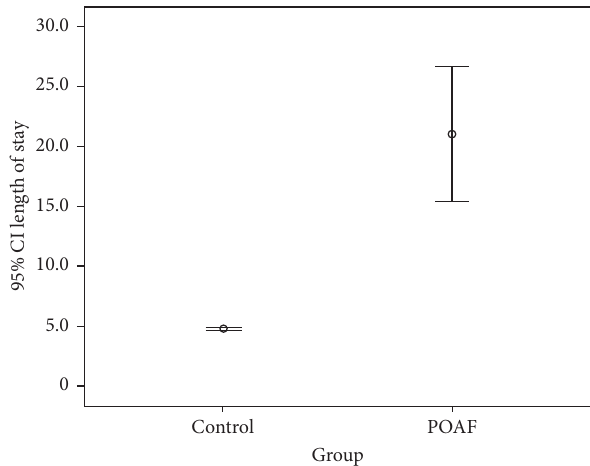
Figure 3: Mean length of stay among study